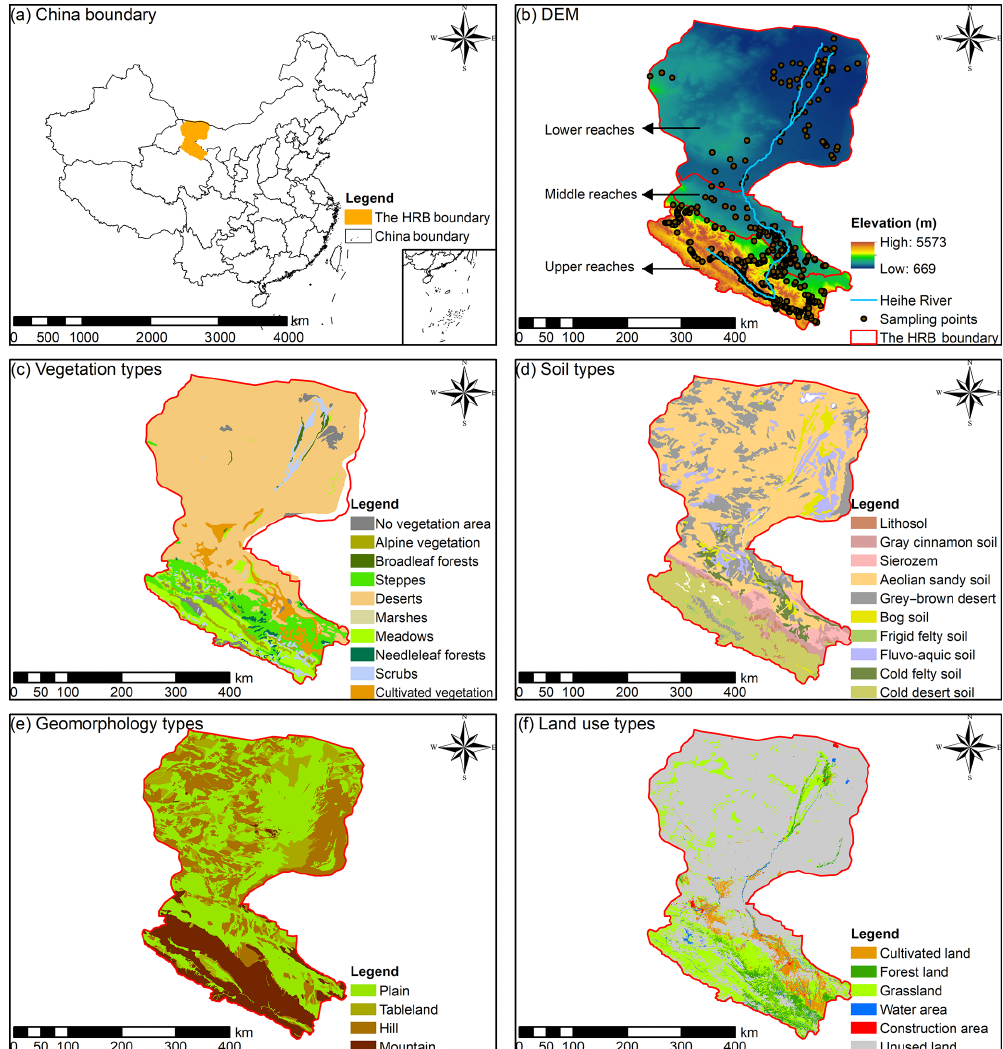
Figure 1. (a) The location of the Heihe River basin (HRB) in China; (b) the distributions of the Heihe River, the elevation and soil sampling points, (c) the vegetation types, (d) the soil types, (e) the geomorphology types, and (f) the land use types in the